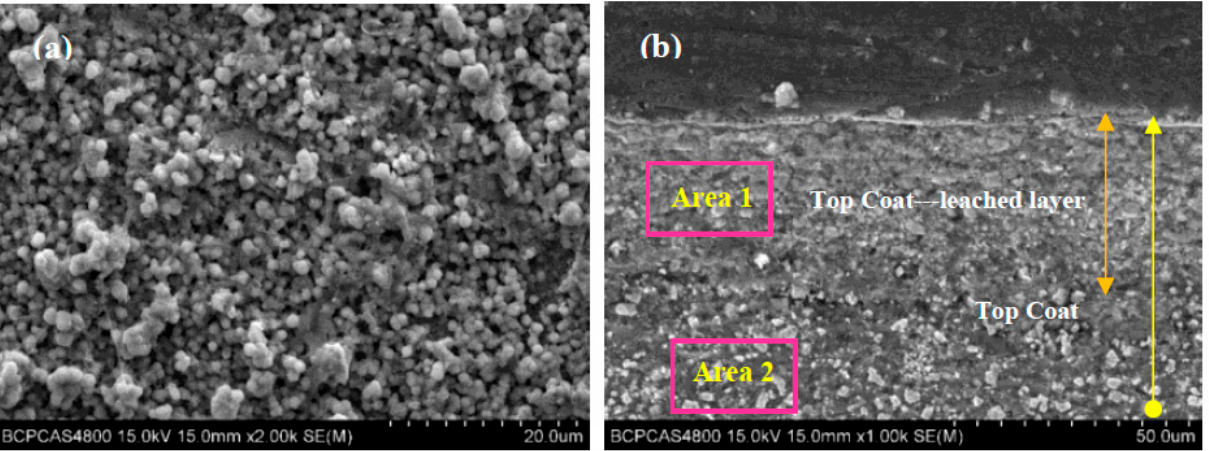
Figure 6. SEM morphology of FW2 coating sample after test for 1700 d: ( a ) surface of antifouling coating; ( b ) cross-section of coating sample.